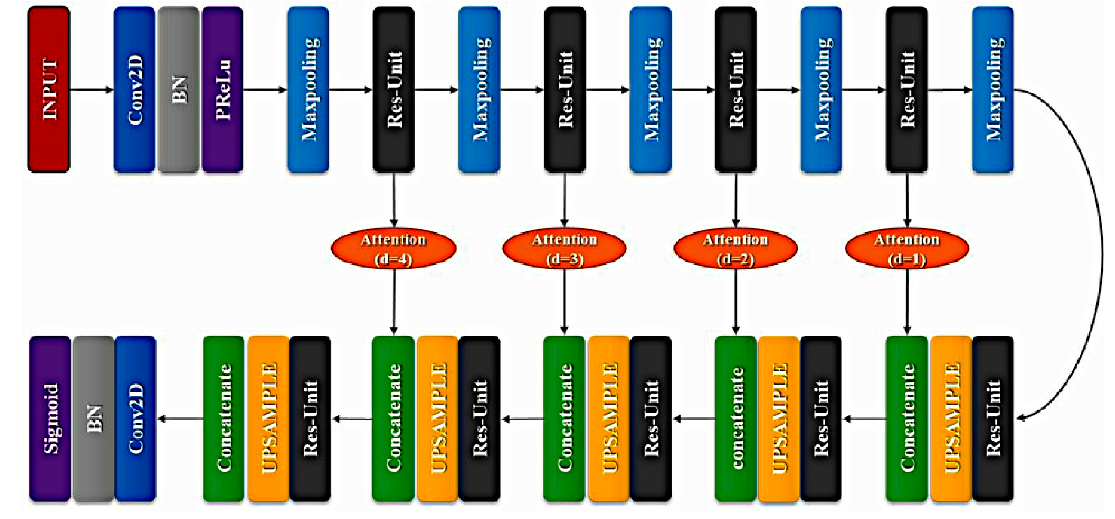
Figure 3. XFinger-Net architecture.